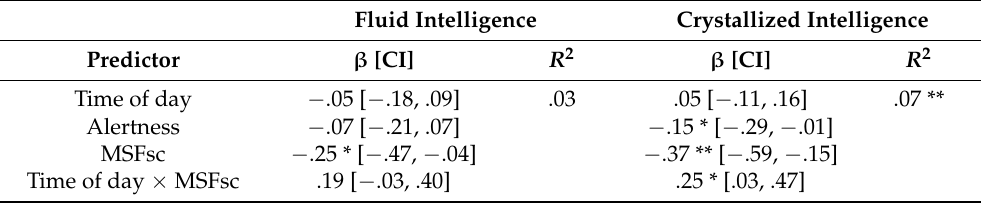
Table 4. Results of a linear regression predicting intelligence after controlling for sleepiness–alertness. Fluid